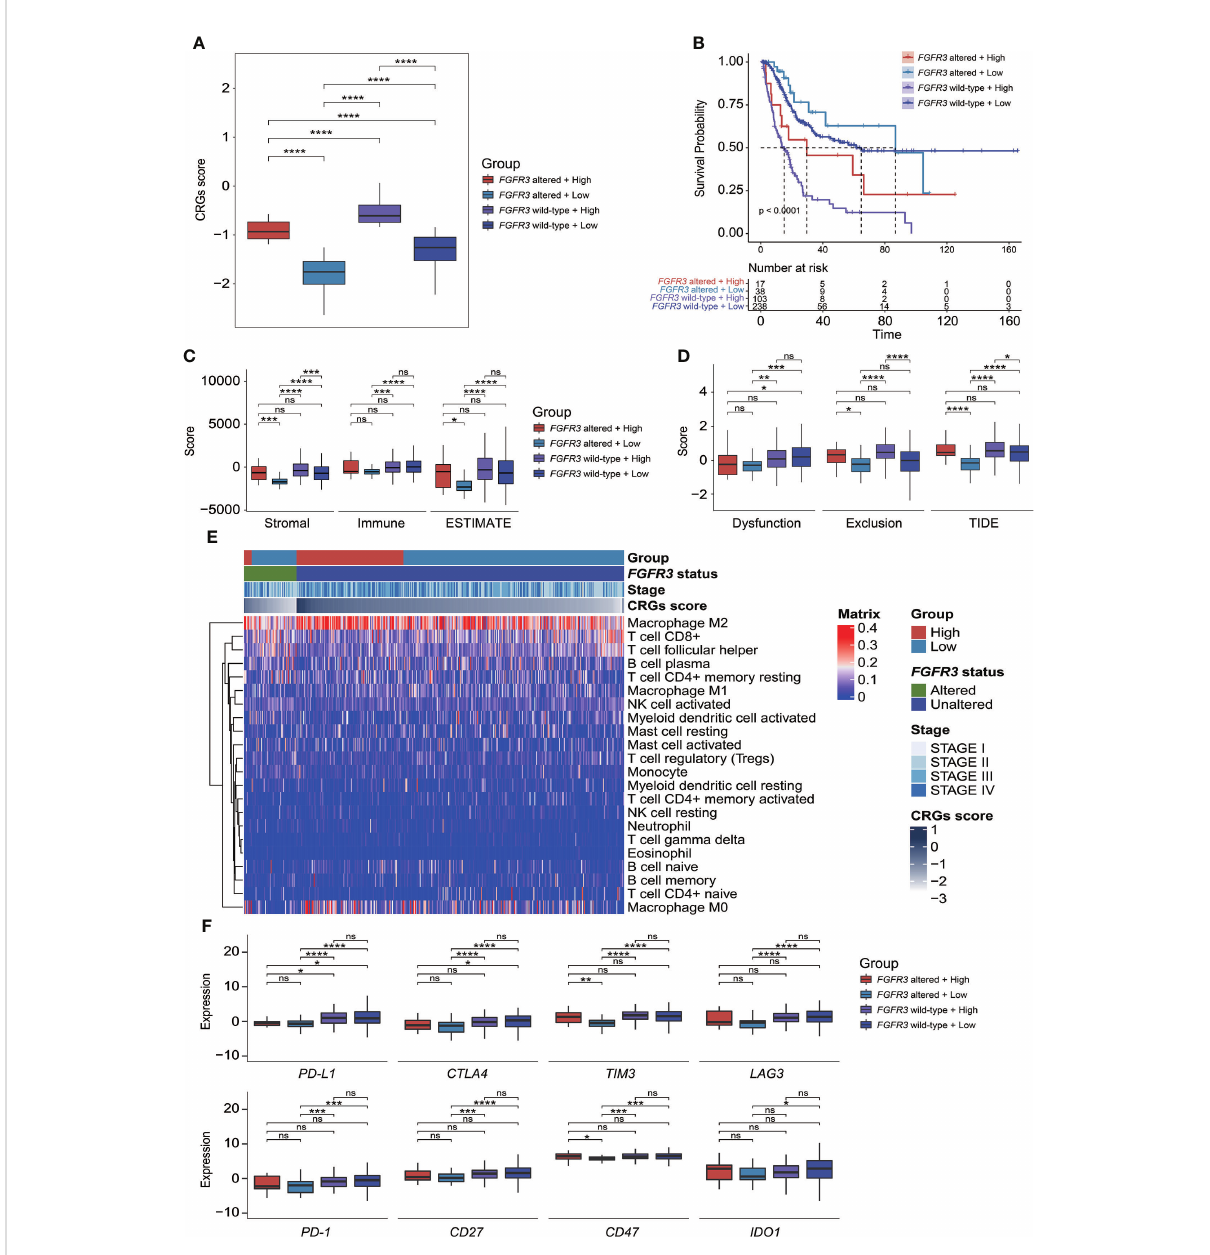
FIGURE 10 The evaluation of tumor microenvironment and immune checkpoint genes ’ expression for patients strati fi ed by CRG signature plus FGFR3 status. (A) Comparison of CRG score between four molecular subgroups. (B) Comparison of survival via the Kaplan – Meier curve analysis between four molecular subgroups. (C) Comparison of stromal, immune, and ESTIMATE scores between four molecular subgroups. (D) Comparison of T-cell dysfunction, exclusion, and TIDE scores between four molecular subgroups. (E) The heatmap exhibited in fi ltrated levels of 22 tumor-in fi ltrated lymphocytes between four molecular subgroups. (F) The comparison of immune checkpoint genes ’ expression levels between four molecular subgroups. *p < 0.05, **p < 0.01, ***p < 0.001, ****p < 0.0001, ns represented “ not signi fi cant ”